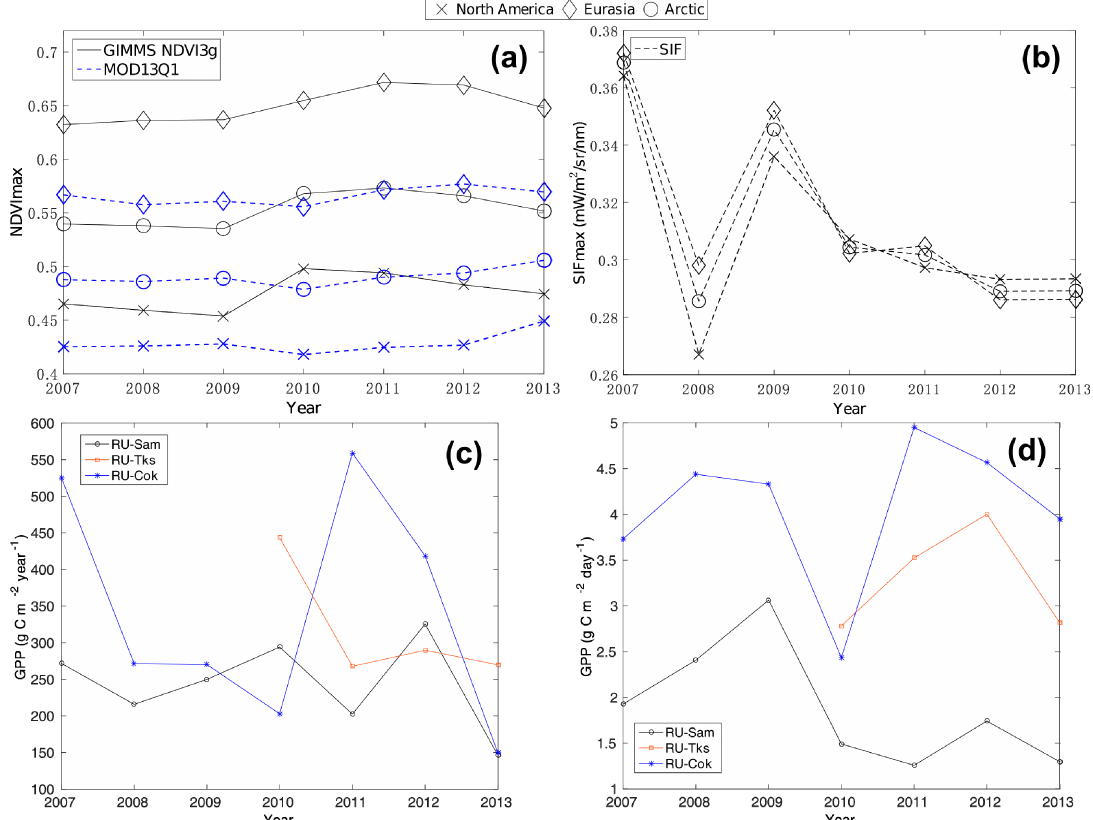
Figure 3. Arctic tundra greenness (average of the annual maximum value) and EC-observed gross primary production (GPP) from 2007 to 2013. ( a ) GIMMS NDVI3g, MOD13Q1, ( b ) SIF, ( c ) annual GPP, and ( d ) maximum value of monthly GPP.